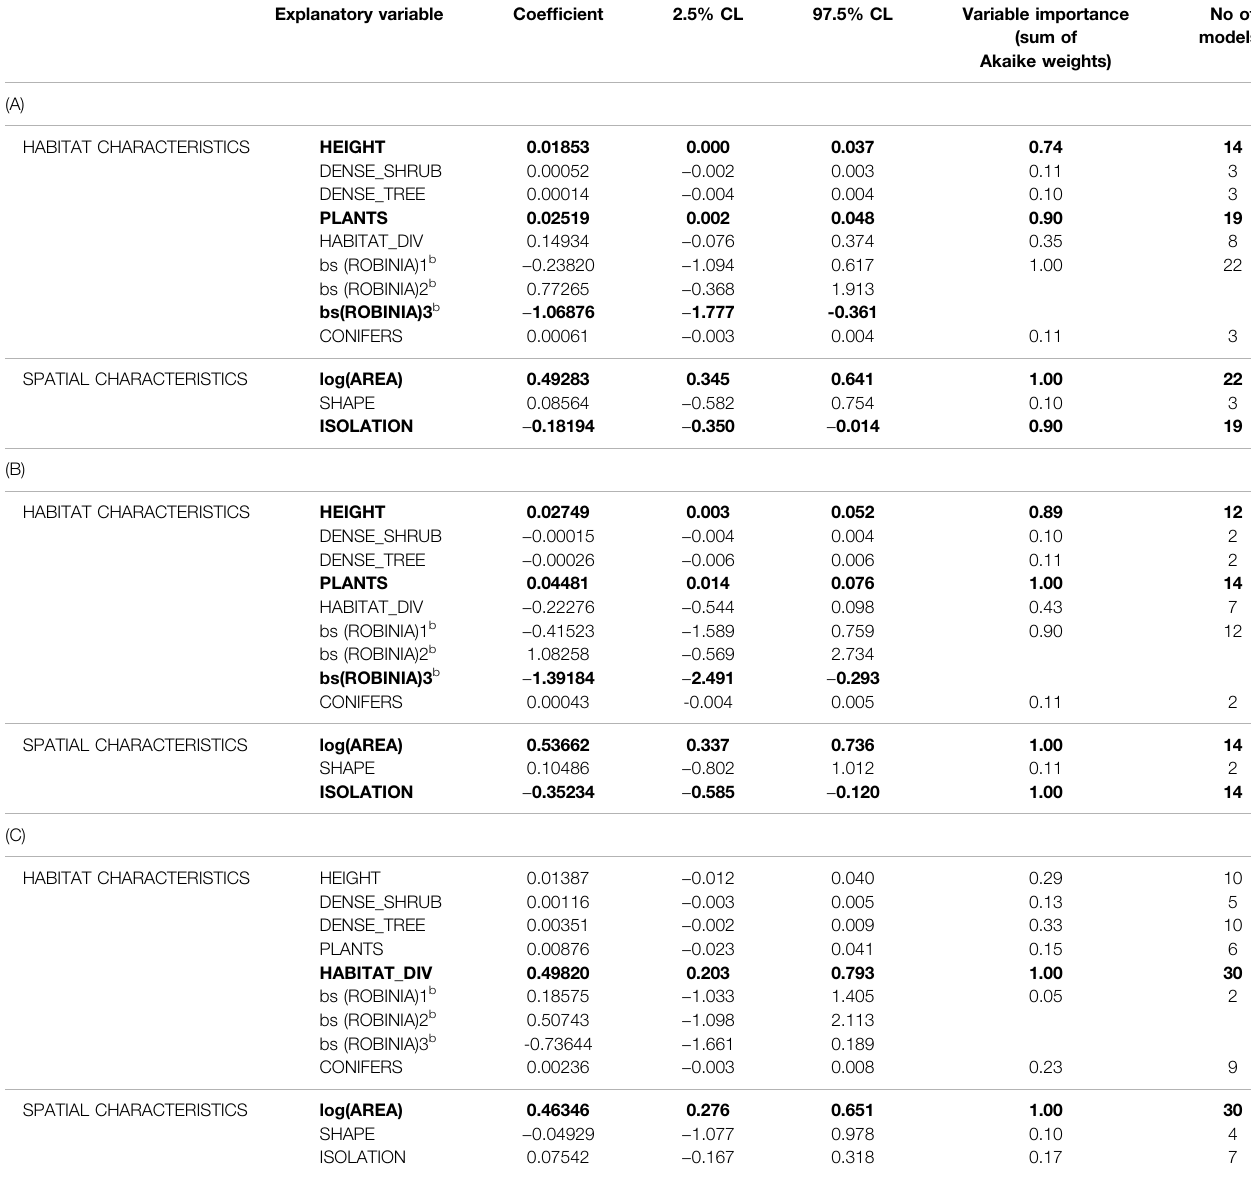
TABLE3| Relationshipsof(A)overallbirdspeciesrichness,(B)forestbirdspeciesrichnessand(C)farmlandbirdspeciesrichnesstowoodlotcharacteristics(see Table1 for their de fi nitions and abbreviations) estimated by generalized linear models. The model-averaged coef fi cients together with their con fi dence limits (CL) across the top models (de fi ned by Δ AIC c < 4; see Supplementary Table S4 ) are shown. Variables with con fi dence limits not including zero are in bold. For results for rare fi ed species richness and the Shannon index see Supplementary Table S5